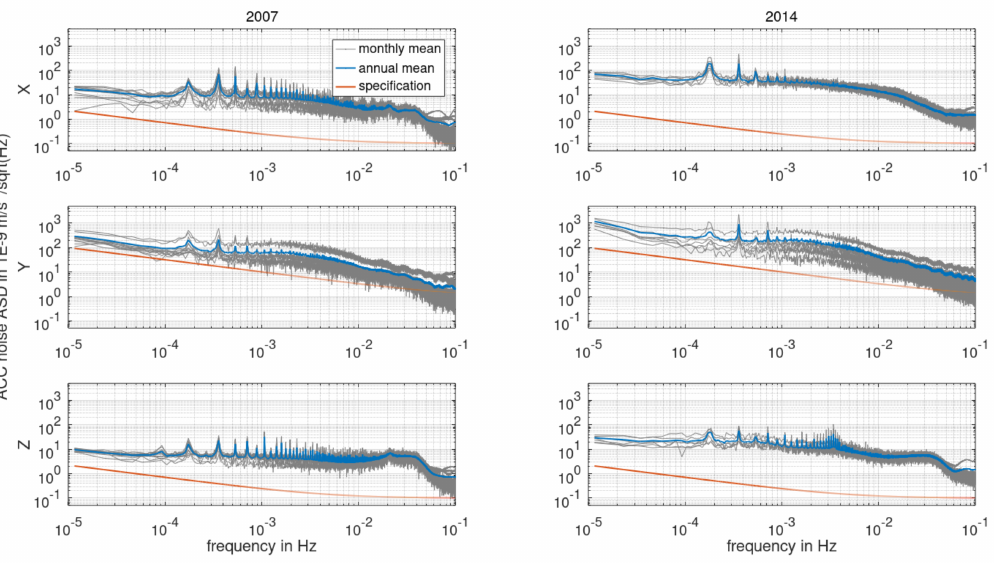
Figure 2. Monthly (gray) and annual (blue) mean noise ASDs of the GRACE ACCs for 2007 ( left ) and 2014 ( right ) for all three axes in the satellite reference frame in comparison with the ACC noise specifications